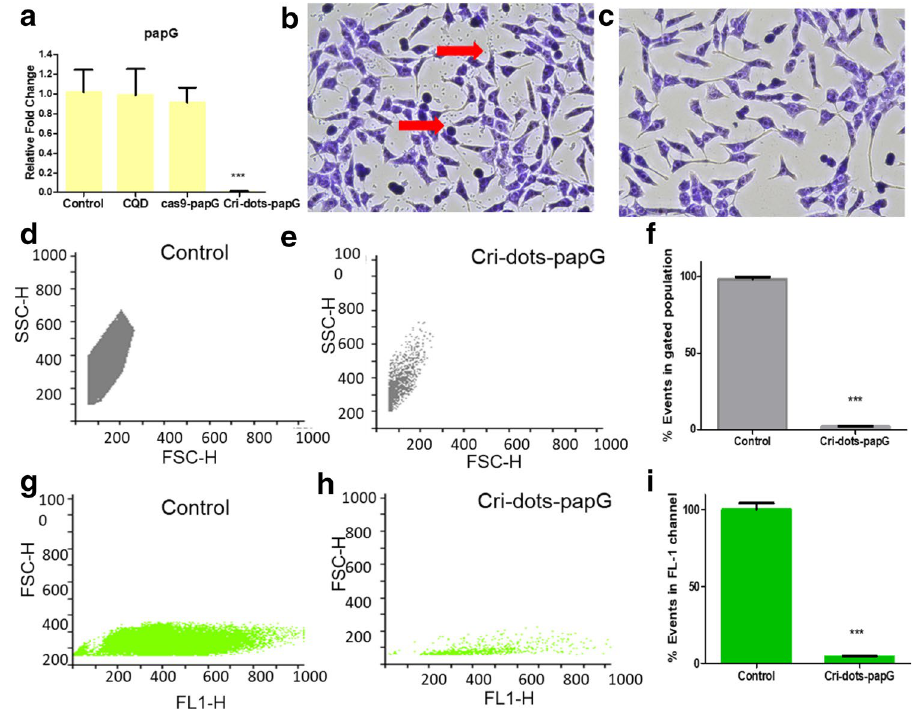
Figure 3. Cri-dots-papG targeting CFT073 inhibited expression of papG and reduced its adherence property. ( a )The relative fold change of papG mRNA in control CFT073 and Cri-dots-papG (1 ± 0.2277, control vs 0.01049 ± 0.002956, targeted). CFT073 treated with only CQDS and cas9-papG showed no significant difference in papG m RNA expression.The data represents an average of triplicate experiments as mean ± SD. (*** p < 0.0001, t test, 2 sided). Adherence Assay ( b , c ). HeLa cells were infected with ( b ) Control CFT073 and ( c ) Cri-dots-papG CFT073 at MOI of 1:5. At 3 h post-infection, the association of bacteria with HeLa cells was visualized by Giemsa staining. Arrows indicate bacteria associated with the HeLa cells. The plates were examined at 20 × . Flow cytometric analysis of adhesion property of Control and Cri-dots-papG CFT073 to Hela cells ( d – i ). Total numbers of events were acquired in 12 µL of sample volume in 60 s for each FCM analysis. Panels represents dot plots of gated population of SYTO9 stained cells ( d , e ) and unstained cells ( g , h ). Panel ( f ) and ( i ) represents the corresponding % of number of events of bacterial cells normalized to control. The data represents an average of triplicate experiments as mean ± SD. (*** p < 0.001, t test, 2 sided).